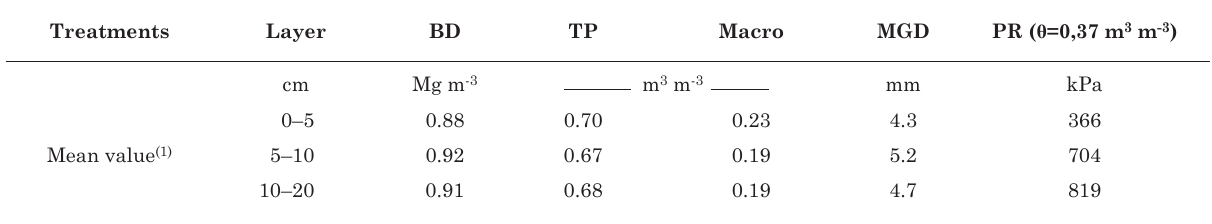
table 4. mean value of physical properties per layer of a humic cambisol amended with dregs and lime rates applied to the surface in 2004/2006. Bocaina do sul, sc, 2010